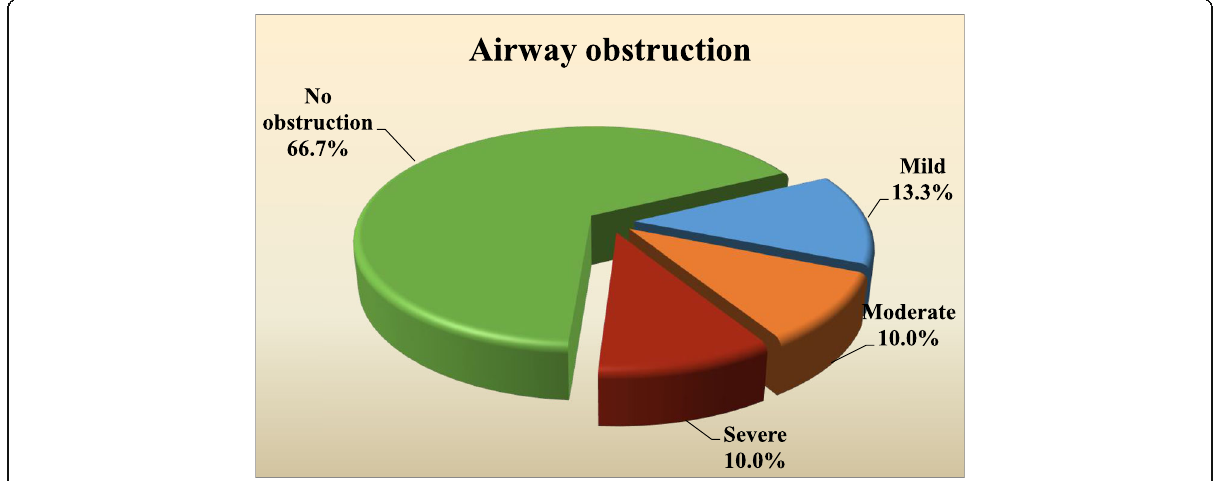
Fig. 8 Percentage of airway obstruction in systemic sclerosis patients in the study according to spirometry